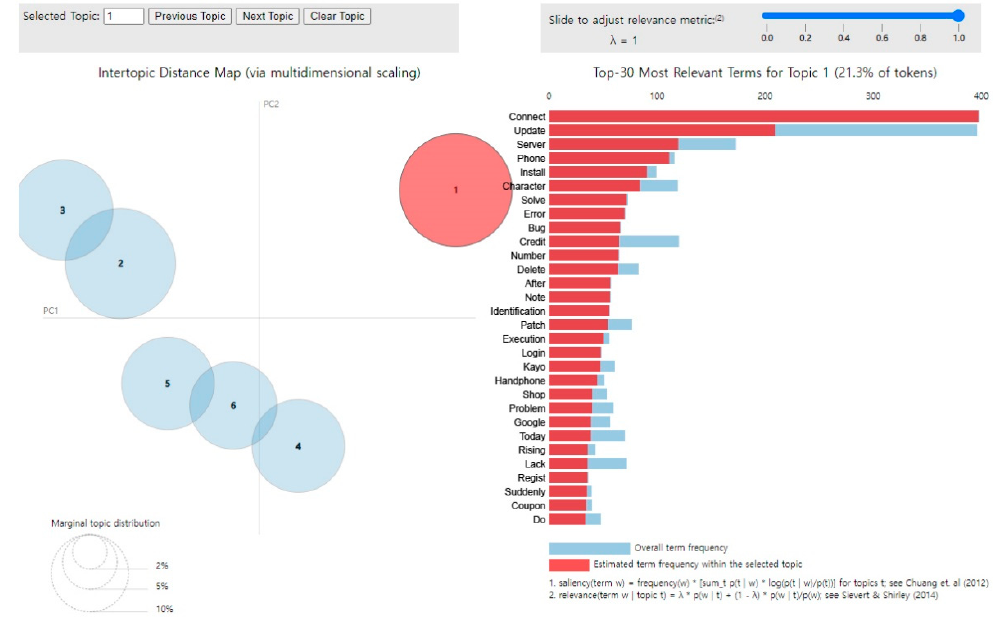
Figure 5. Visualization example using pyLDAvis.